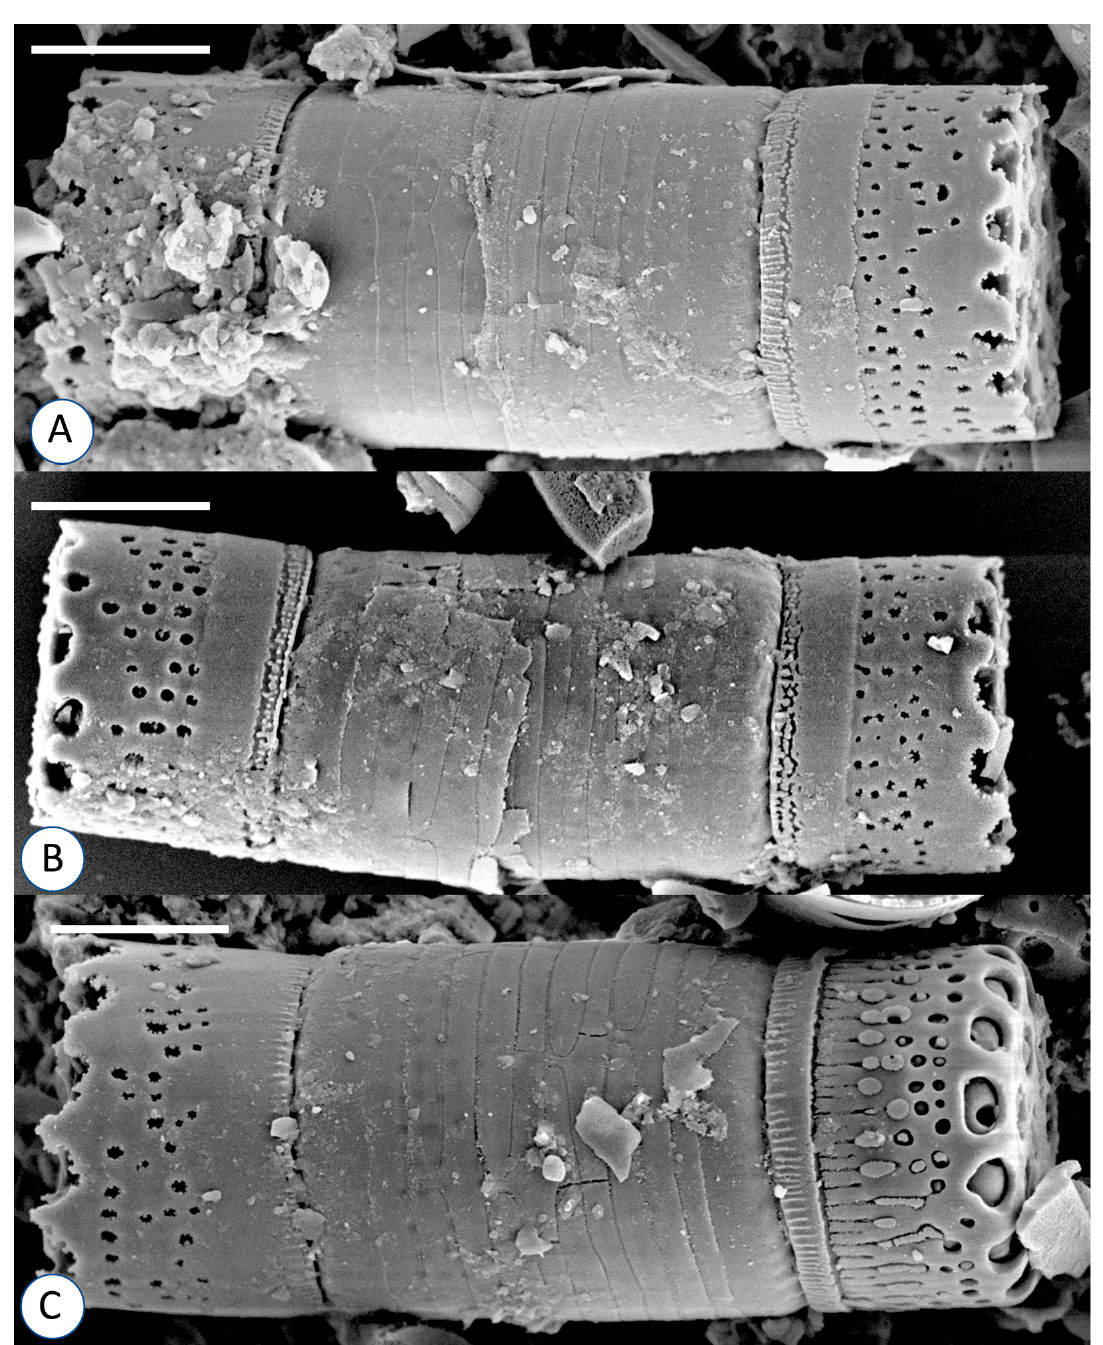
Figure 3. ( A – C ) Aulacoseira wyomingensis , sp. nov. Scanning electron microscopy. External girdle views of entire frustules. Valves have striae that are disorganized. Column has small ridges. Cingulum is composed of numerous ligulate elements. Spines are small in length and shield-like. Valve on the right in ( C ) appears to be incompletely formed. Scale bars = 5 µm.